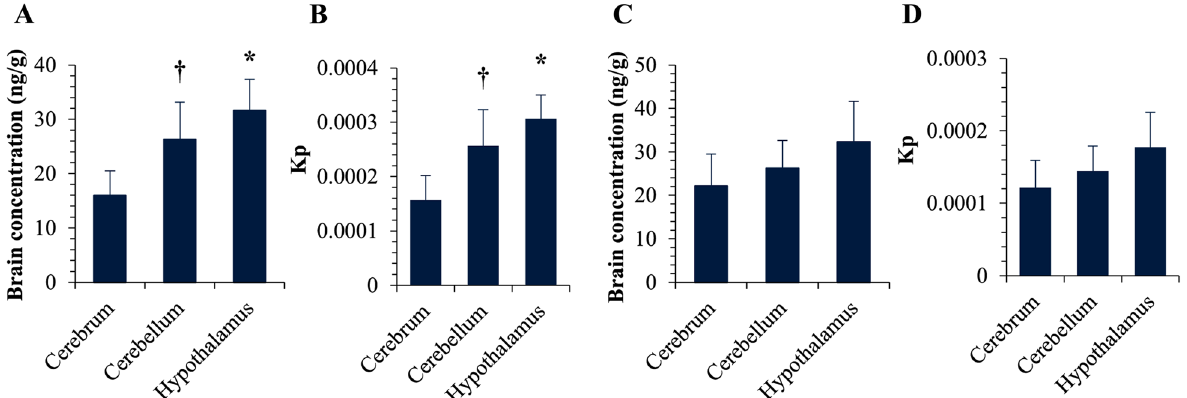
Fig. 4 Brain distribution of liraglutide in rats represented by A brain concentration and B tissue-to-plasma partition coefficient ( K p ) following intravenous (IV) injection and C brain concentration, and D K p following subcutaneous (SC) injection in rats (mean cerebrum; * p < 0.05 versus cerebrum and